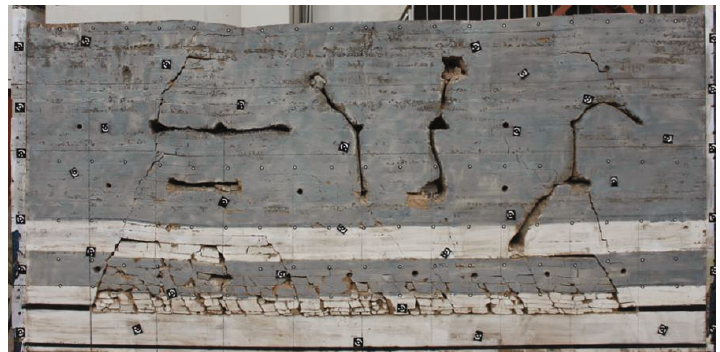
Figure 5: Water inrush passage in the overburden (mining distance is 480 m).